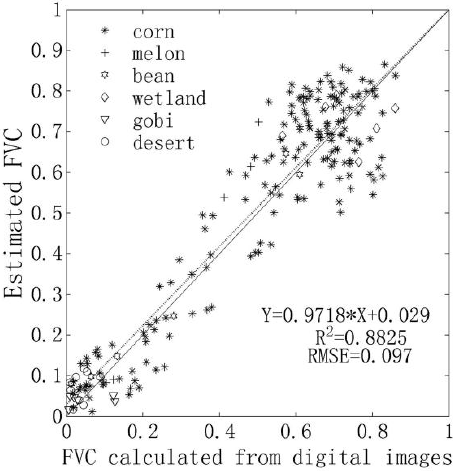
Figure 7. Comparison of the FVC estimates from Landsat 7 ETM+ reflectance data using the proposed algorithm and those extracted from the field photos in Heihe region.